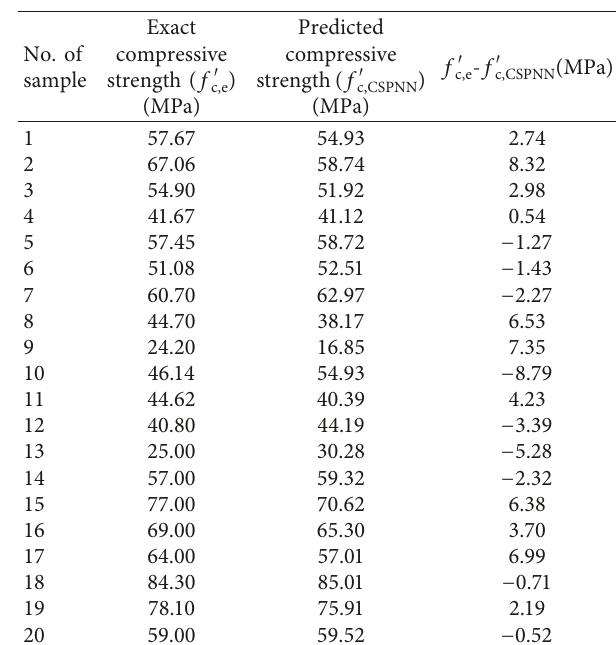
Table 9: Comparison of exact compressive strength with CSPNN- predicted compressive strength for the 20 testing